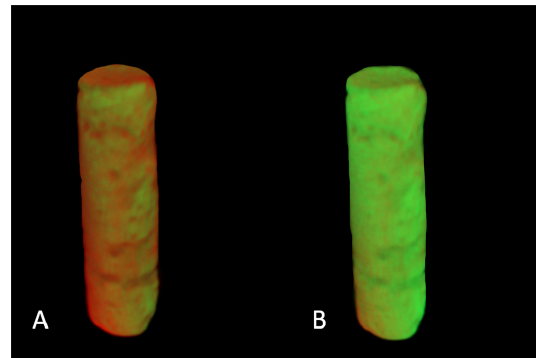
Figure 2 - 3D models created in CTVox software illustrating the volumetric change before (green) and after (red) immersion in distilled water . A: representative image of volume gain after immersion. B: representative image of volume loss after